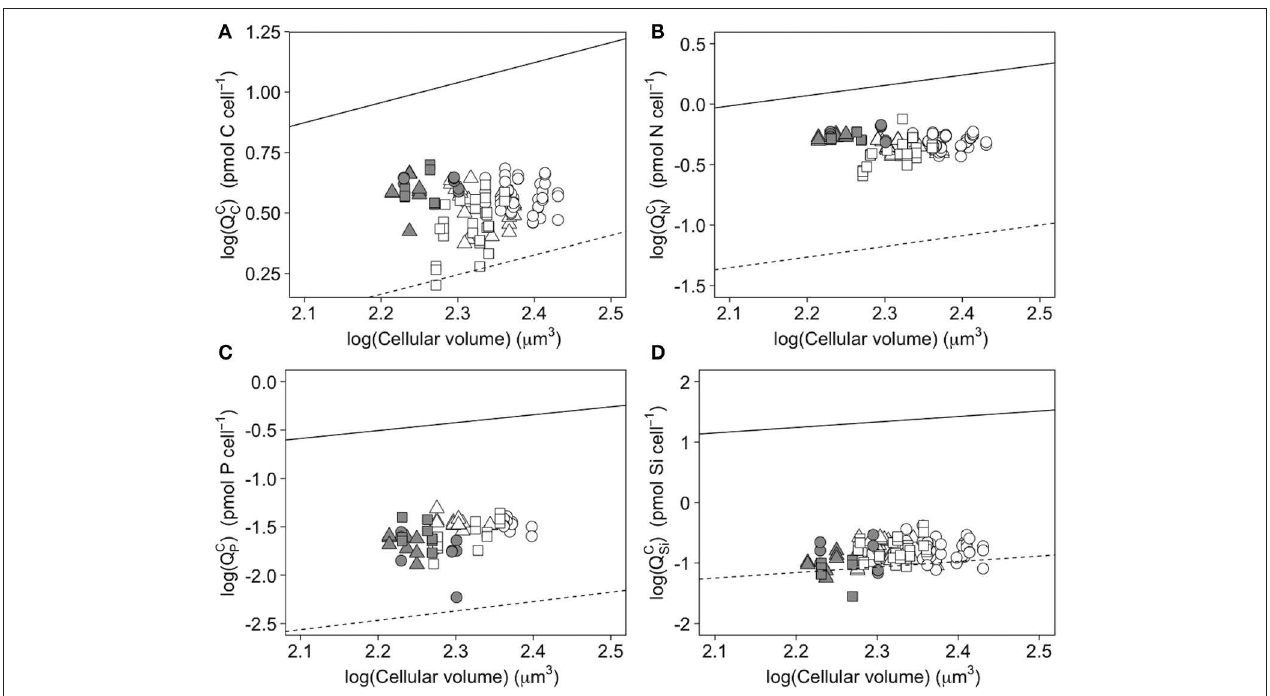
FIGURE 4 | Log-log plots of cellular elemental quotas vs. cellular volume for carbon (A) , nitrogen (B) , phosphorus (C) , and silicon (D) in C. gelidus cells acclimated to NH + 4 (circles), NO − 3 (triangles) and urea (squares) under low (5.5 µ mol photons m − 2 s − 1 ; gray symbols) and high (200 µ mol photons m − 2 s − 1 ; white symbols) light at 0 ◦ C. Data are shown for all experimental replicates ( n > 9). Allometric relationships for other polar and temperate diatoms are given by the solid and dashed lines, respectively (see references in Lomas et al., 2019).